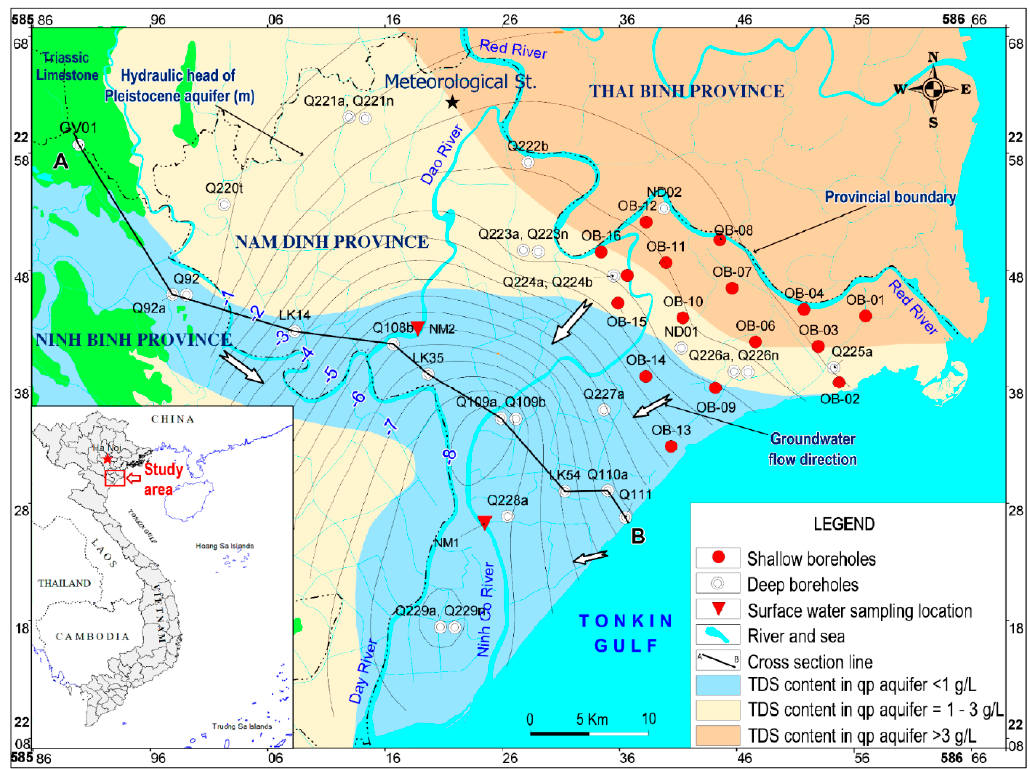
Figure 1. Map showing the study site: southern part of the Red River’s Delta plain: Thai Binh, Nam Dinh, and Ninh Binh provinces; sampling locations for groundwater of Holocene aquifer ( ● points), surface water ( ▼ points); saline-brackish-fresh water boundary; and isolines of water hydraulic head of groundwater in Pleistocene (qp) aquifer.